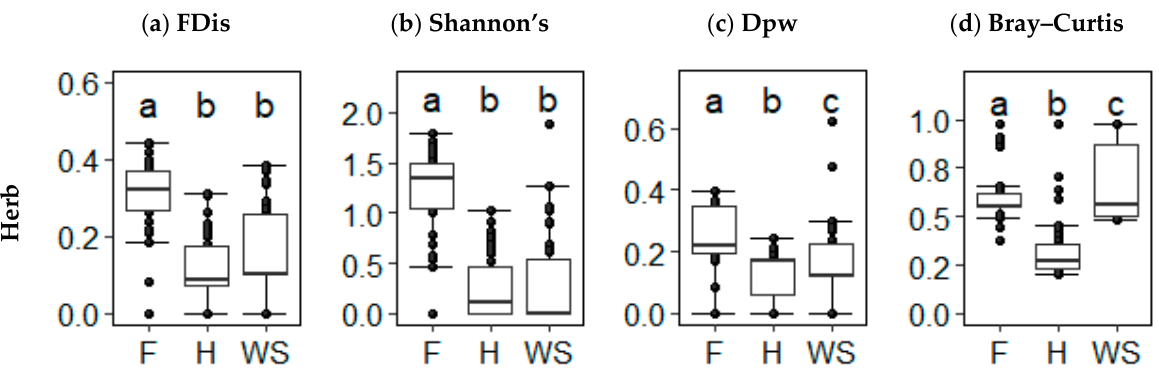
Figure 6. ( a ) Functional alpha diversity (functional dispersion), ( b ) taxonomic alpha diversity (Shannon’s diversity), ( c ) functional beta diversity (functional pairwise dissimilarity), and ( d ) taxonomic beta diversity (Bray–Curtis dissimilarity) values for herbs in forest (F) ( n = 40), heath (H) ( n = 45), and shrub savannah (SS) ( n = 45) alternate states. Unlike letters above the error bars indicate significant differences at p < 0.05.